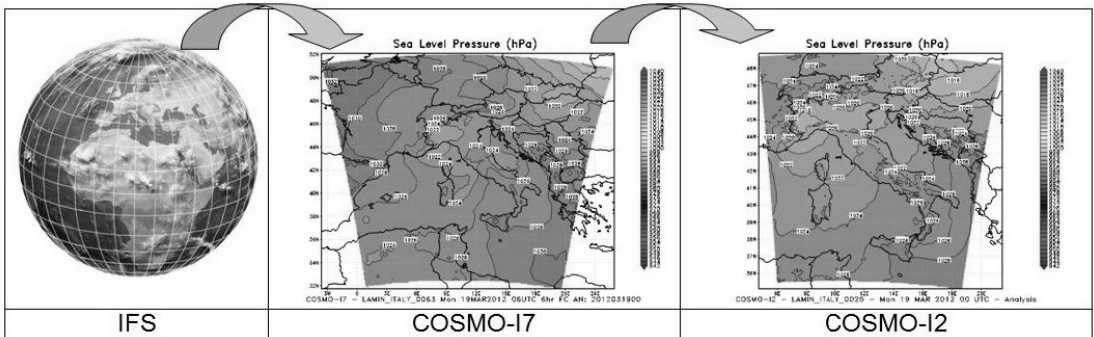
Figure 1. Physical downscaling model.